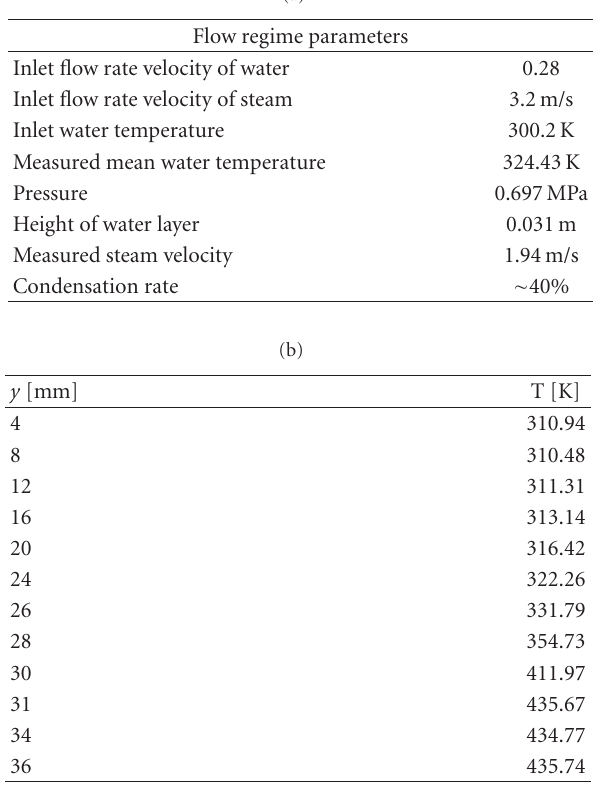
Table 2: Flow regime parameters and measured temperature